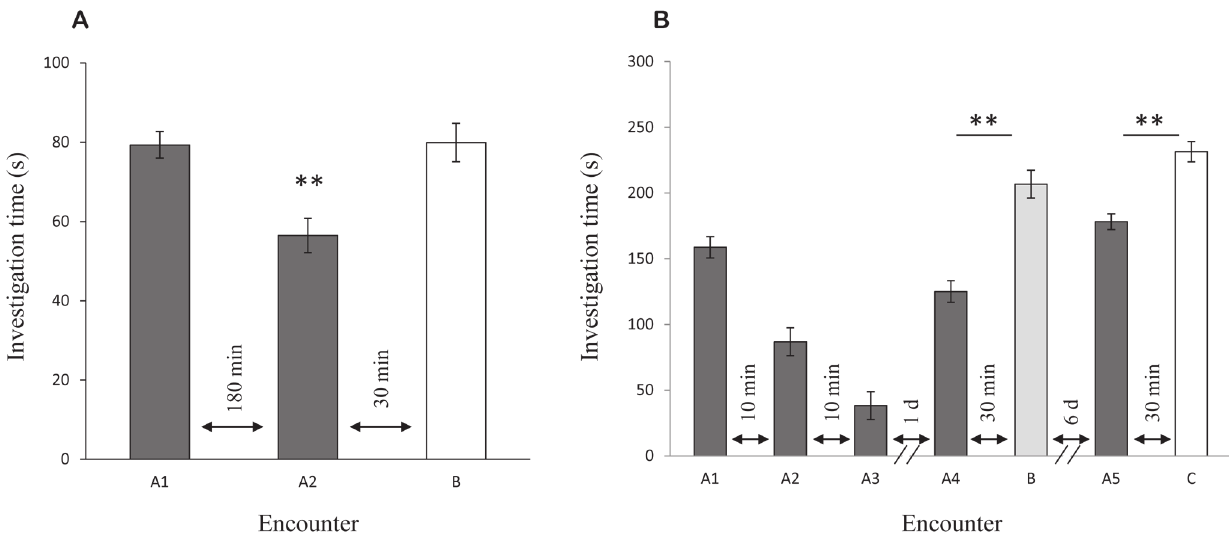
Figure 1. Adult male rats acquired long-term SRM (mean ± SEM): Adult male rats (n=18) showed a significant reduction in social investigation time (SIT) during the second encounter with a juvenile (A2) 180 min after the first encounter with the same animal (A1). This SIT was also less than during an encounter with a novel juvenile (B) 30 min later. All encounters lasted 2 min. No significant difference was found between the two encounters with a novel juvenile (A1,B). Repeated ANOVA: F (2,34) =22.72, p , 0.001, Bonferroni post hoc : ** p , 0.01. A) After three consecutive 5 min encounters with the same juvenile (A1–3), adult male rats (n=8) retained long-term SRM, assessed by the significant difference in SIT between the encounters with this juvenile and novel one (1 d - A4 vs. B; 7 d - A5 vs. C) 30 min later. Paired t-test: ** p ,